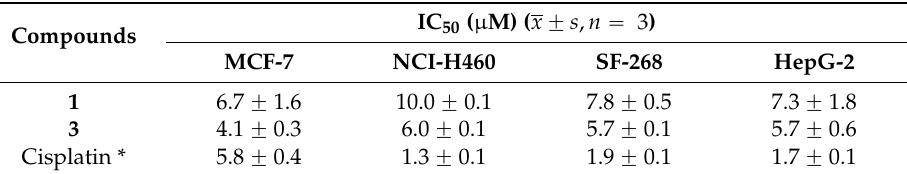
Table 2. Growth-inhibition effects of compounds 1 and 3 .